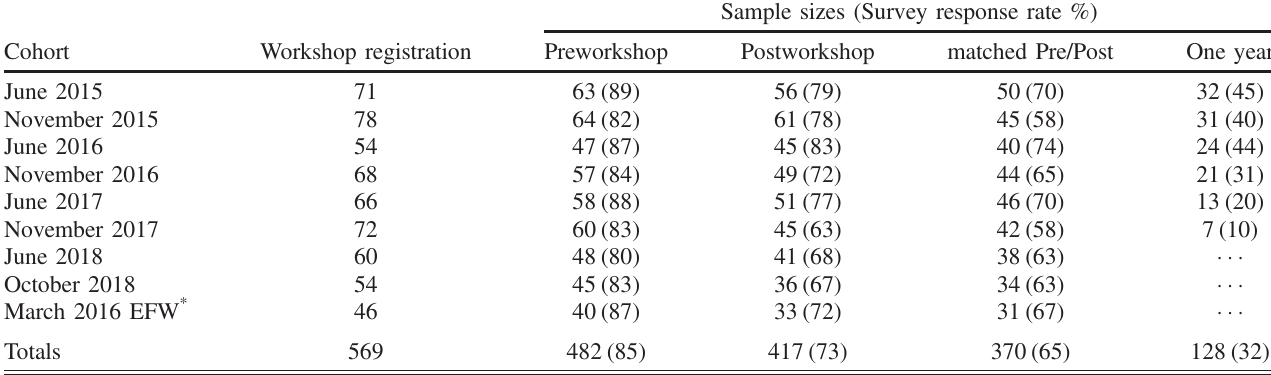
TABLE II. Sample sizes for workshop surveys.